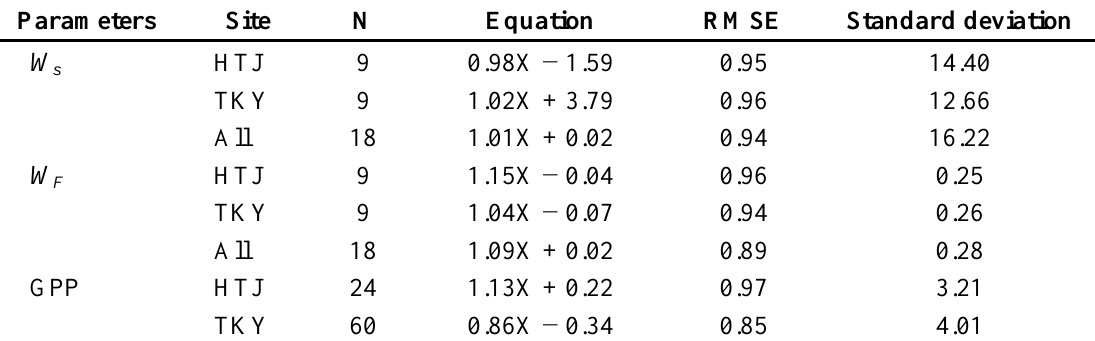
Table 4. Summary of linear regression statistics of estimated versus observed values of (TKY). The error terms were presented as the standard deviation